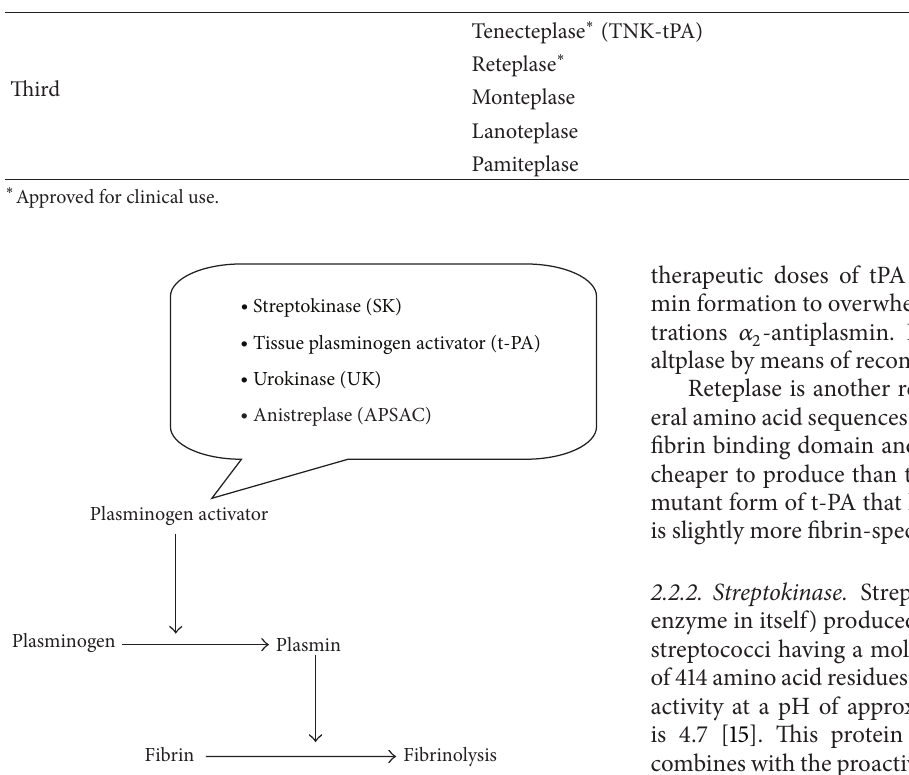
Figure 1: Schematic representation of